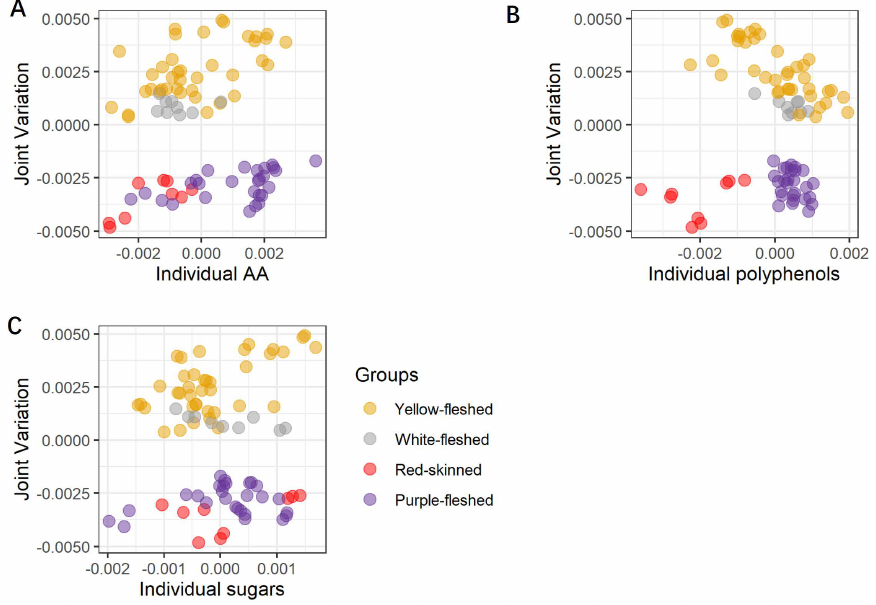
Figure 1. Score plots of the joint part of the three joined datasets, and the individual parts of the three separated datasets are reported as joint and poly ( A ), joint and sug ( B ), and joint and AA ( C ). The joint part gathers all three datasets (poly, sug, AA). The poly dataset includes the individual polyphenols, the sug dataset includes the individual sugars, and the AA dataset includes ABTS, FRAP, and FC assays. The 28 potato samples are organized into four groups (yellow-, white-fleshed, red-skinned, and purple-fleshed), which are highlighted using four different colors yellow, grey, red, and purple, respectively. For each steam-cooked potato sample, the three corresponding biological replicates are graphically presented as points and using the corresponding group color. AA = antioxidant activity, Poly = single polyphenols, Sug = sugars.